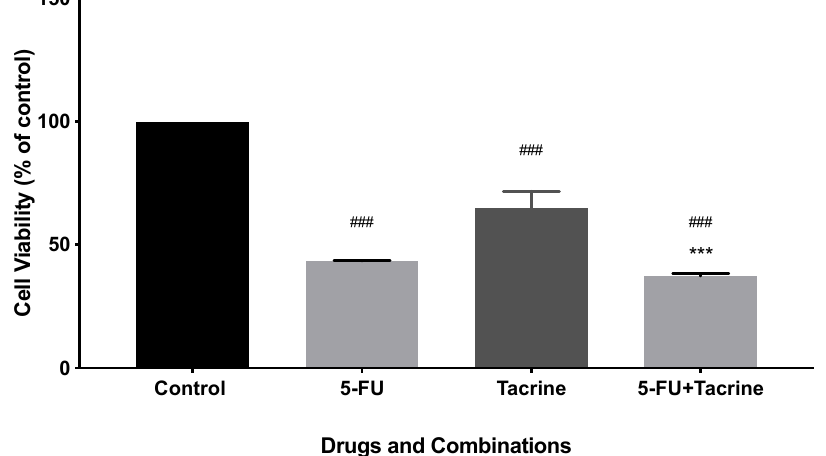
Figure 1. Effect of Tacrine and 5-Fluorouracil (5-FU) on the viability of MCF-7 cells. Results are presented as mean ± standard error of the mean (SEM) and represent the viability of cells (% of control) of three independent experiments ( n = 3). ### p < 0.001 vs. control; and *** p < 0.001 vs. single drug of the combination with more effect on cell viability reduction.